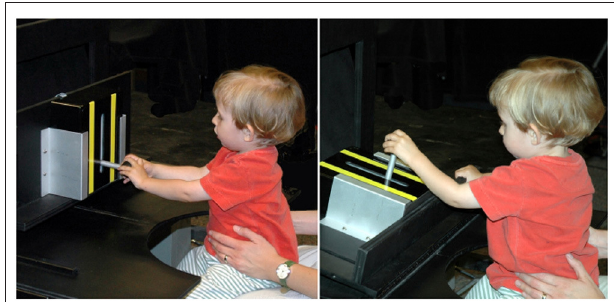
FIGURE 1 | Experimental setting: A box with a lever was mounted on a black board with aluminum braces. The box could be oriented to enable vertical or horizontal movement of the lever. The box and environment were visually nondescript, besides two yellow stripes indicating the movement direction. While the lever was being moved, the box played